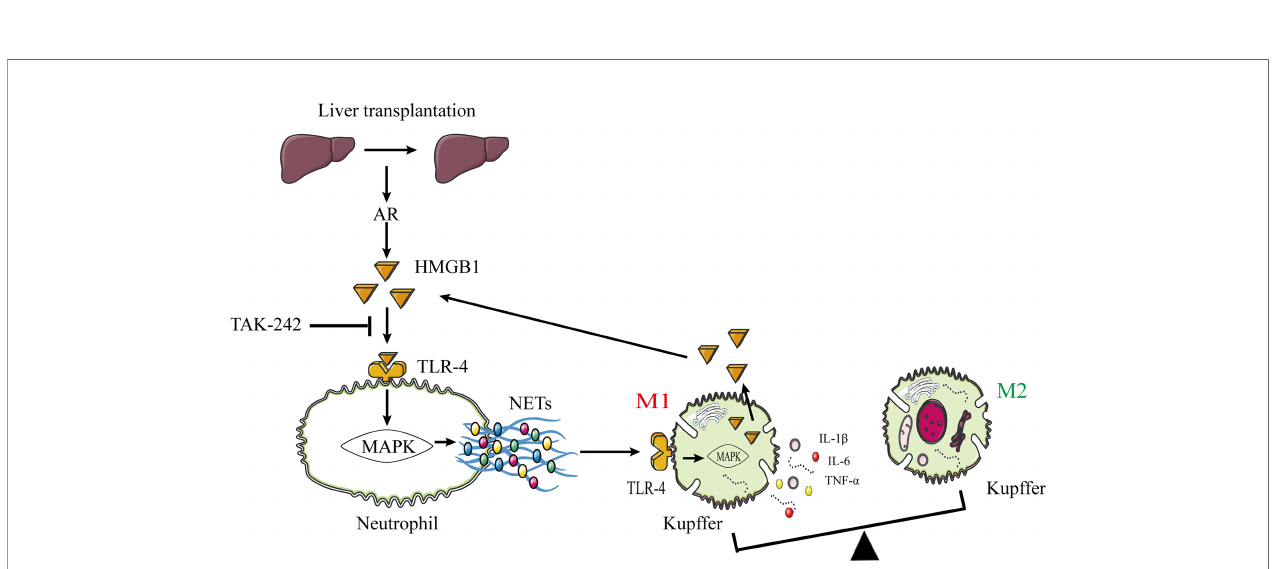
FIGURE 10 | The proposed model shows that NETs induce M1 polarization of Kupffer cells and HMGB1 translocation via HMGB1/TLR-4/MAPK signaling pathway during AR following liver transplantation. HMGB1 promotes NET formation by activating the HMGB1/TLR-4/MAPK signaling pathway. NETs stimulate M1 polarization of Kupffer cells and HMGB1 intracellular translocation. Subsequently, HMGB1 is released into the extracellular milieu to aggravate liver injury. HMGB1, high-mobility group box 1 protein; TLR-4, toll-like receptor 4; MAPK, mitogen-activated protein kinase; AR, acute